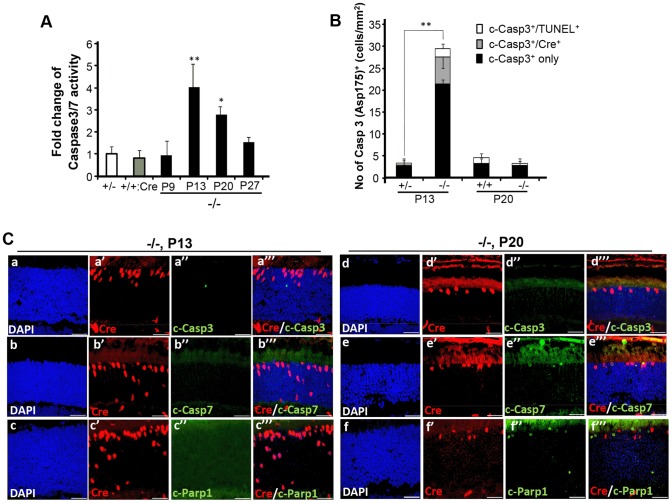
Spatiotemporal activation of caspases 3 and 7 and Parp1 in photoreceptors of HRGP-cre:Ranbp2−/− mice.(A) Temporal profile of caspase 3/7 activation of retinal extracts of HRGP-cre:Ranbp2−/− mice (−/−) mice relative to age-matched +/− controls shows significant caspase3/7 activation at P13 and P20. The caspase 3/7 activities of +/− and +/+:Cre controls shown are at P20. (B) Quantitative, temporal and relative distributions between activated (cleaved) caspase 3 (c-casp3+), Cre+ and TUNEL+ in cell bodies of photoreceptors of HRGP-cre:Ranbp2+/− (+/−) and HRGP-cre:Ranbp2−/− mice (−/−) at P13 and P20. The majority of photoreceptor cell bodies are c-casp3+Cre−. The levels of any type of c-casp3+ cell bodies are negligible by P20. (C) Relative immunolocalizations of Cre+ and c-casp3+ (a–a′″, d–d′″), Cre+ and c-casp7+ (b–b′″, e–e′″), and Cre+ and activated Parp1 (c-Parp1+) (c–c′″, f–f′″) cell bodies of photoreceptors of HRGP-cre:Ranbp2−/− mice at P13 (a–c′″) and P20 (d–f′″). c-casp3+ develop at P13, c-casp7+ and c-Parp1+ at P20 and all c-Parp1+ cell bodies are Cre−, whereas c-casp7+ are Cre+. Legend: Data shown represent the mean ± SD, n = 4–5; *; p<0.05, **; p<0.01; scale bars = 25 µm; cleaved caspases 3 and 7, c-casp3 and c-casp7, respectively.